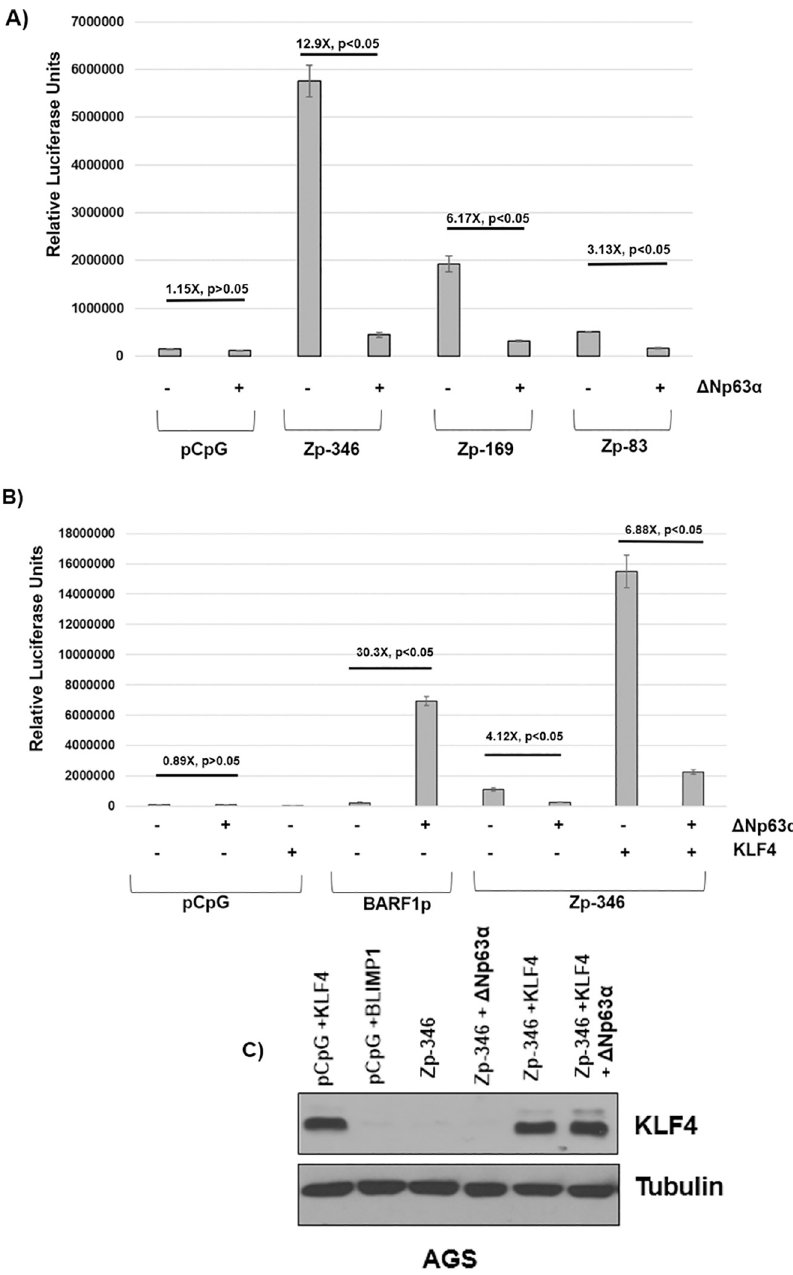
Fig 9. Δ Np63 α inhibits Z promoter activity in reporter gene assays. A) Luciferase vectors containing various amounts of the Z promoter sequence, or the pCpG (promoterless) negative control vector, were transfected into EBV- negative AGS gastric carcinoma cells with or without an Δ Np63 α expression vector. Luciferase activity was measured two days later. The average fold change in luciferase activity in Δ Np63 α transfected cells versus control vector transfected cells for each promoter construct is shown, with error bars indicating standard error. Analysis of statistical significance between Δ Np63 α and control conditions in the pCpG vector, Zp-346 vector, Zp-169 vector, and Zp-83 vector was performed using a two-sample t-test as indicated. B) AGS cells were transfected with the pCpG negative control luciferase vector, or luciferase vectors driven by the EBV early lytic BARF1 promoter, or the Z (Zp-346) promoter, in the presence or absence of a KLF4 expression vector, with or without co-transfected Δ Np63 α , as indicated. The average fold change in luciferase activity for each condition (relative to each promoter construct transfected with control vector) is shown, as well as the standard error. Analysis of statistical significance between Δ Np63 α and the control or KLF4 conditions in the pCpG vector, BARF1p vector, and Zp-346 vector was performed using a two-sample t-test as indicated. C) Immunoblot analysis of the Zp-luciferase assay samples shown in Fig